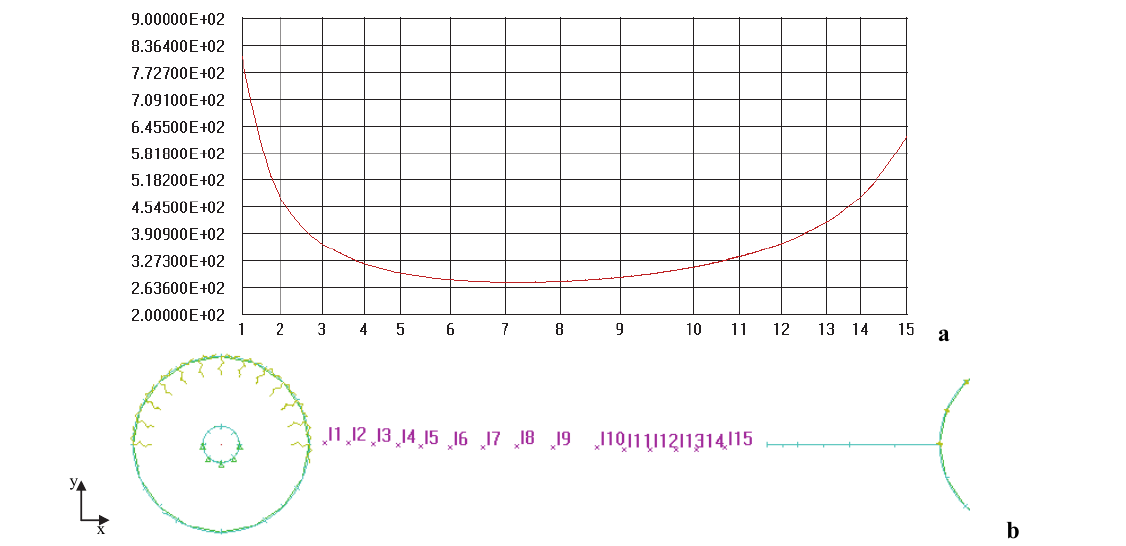
Figure 10a-b: Von Mises stresses (a) calculated with a load of 143MPa on the internal points (b) between crack tip N. 1 and hole N. 4 (see Fig. 7d).